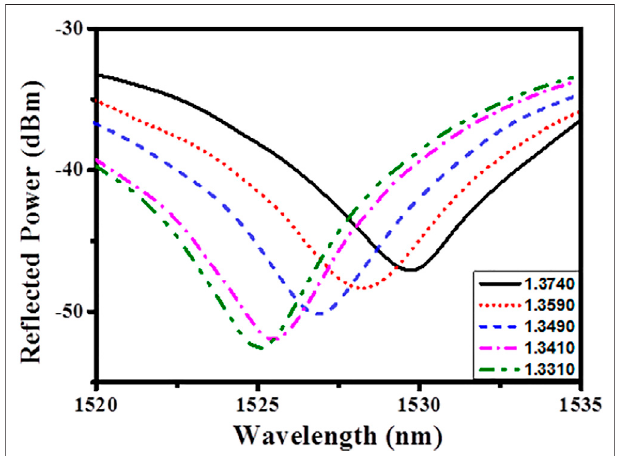
FIGURE3| ShiftininterferencepatternwithRIofdifferentchemicalsand n is fi xed at 5.